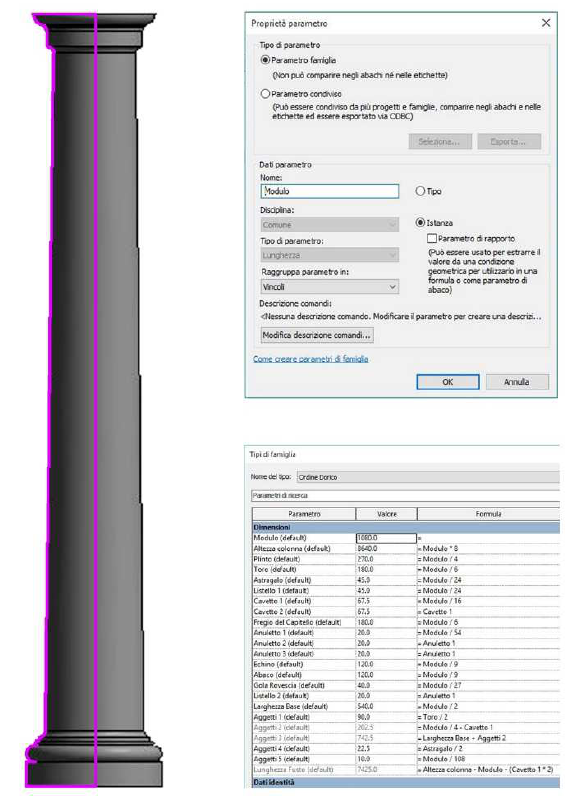
Figure 5. Revit 3D model of Doric Column, parameters properties and family type with mathematical